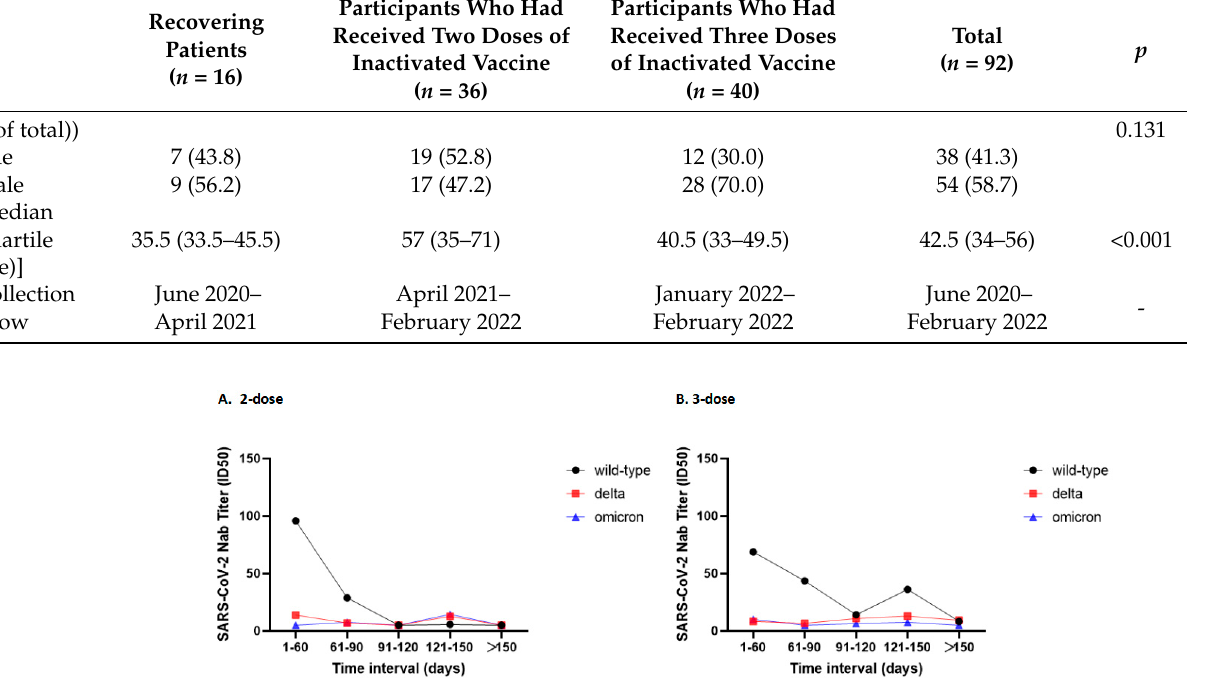
Figure 1. Association between the time interval from vaccination to serum collection and antibody titers against various pseudoviruses. ( A ) Neutralizing Ab titers of two-dose vaccine recipients against wild-type, Delta and Omicron strains. ( B ) Neutralizing Ab titers of three-dose vaccine recipients against wild-type, Delta and Omicron